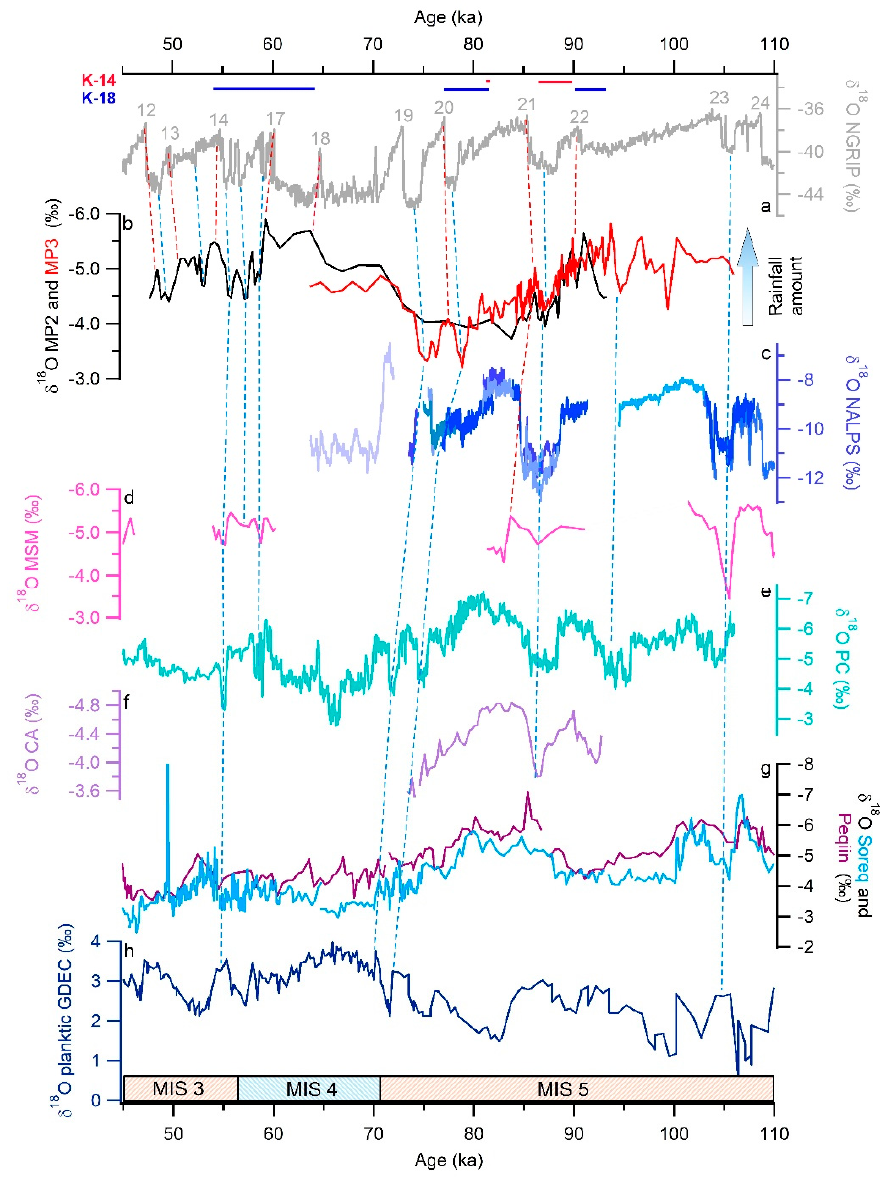
Figure 5. Comparison of δ 18 O records from ( a ) the NGRIP ice core δ 18 O record [2]; ( b ) Manita pe ć Cave stalagmites MP-2 and MP-3; ( c ) NALPS record from the North Alps caves [4]; ( d ) Mala Špilja Cave from Mjet Island [27]; ( e ) Pozzo Cucú Cave [25]; ( f ) Crovassa Azzurra Cave [24]; ( g ) Soreq and Peqiin caves in Israel [33]; and ( h ) marine borehole GDEC-4-2 [59]. Numbers refer to Greenland Interstadials. Dashed lines indicate the most prominent matches of recorded stadials (blue) and interstadials (red). Horizontal bars represent growth episodes of speleothems K-14 (red) and K-18 (blue) recovered from the submerged U Vode Pit (Krk Island) [101].